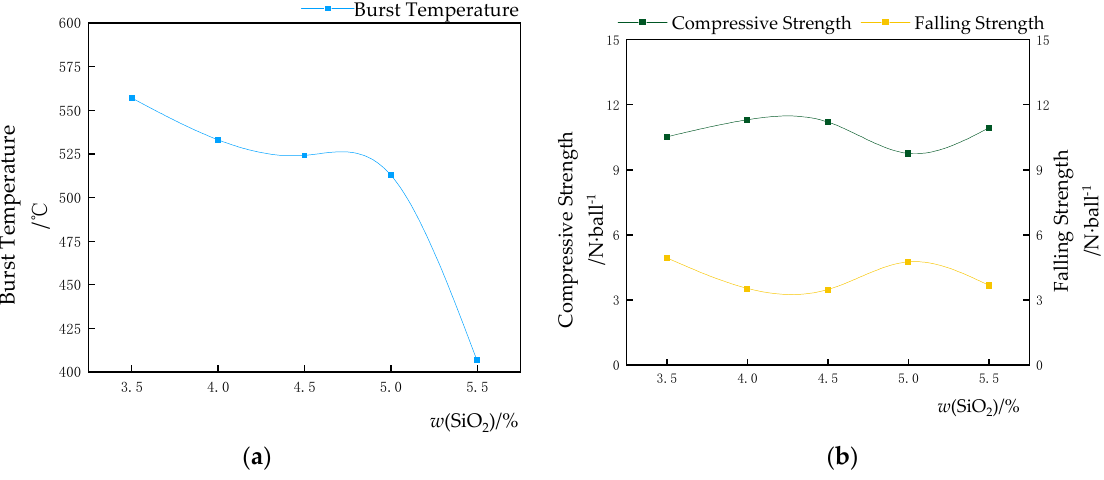
Figure 2. Effect of SiO 2 content on green pellet performance. ( a ) Burst temperature trend chart, ( b ) Compressive strength and falling strength trend chart.